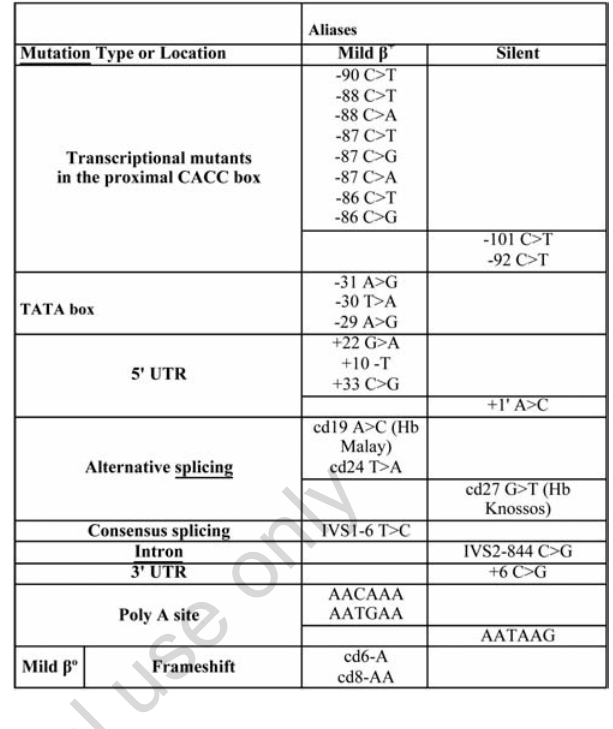
Table 1. Mild and Silent HBB Mutations causing β